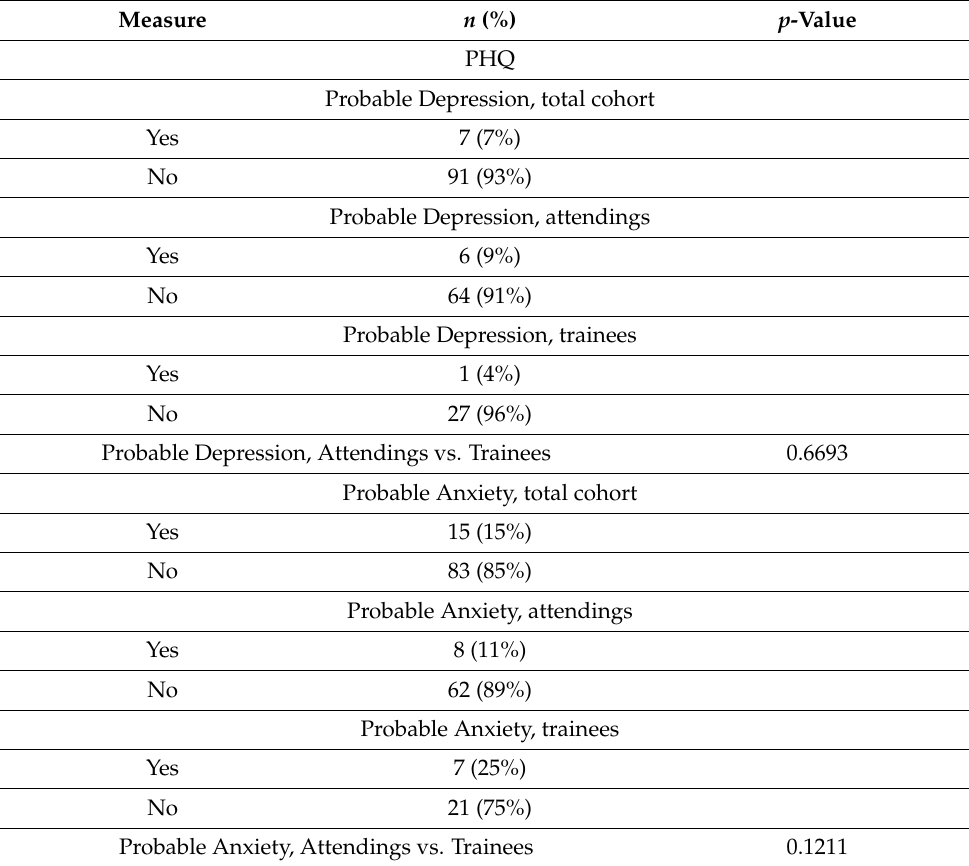
Table 3. Survey Responses for Probable Depression and Probable Anxiety *.